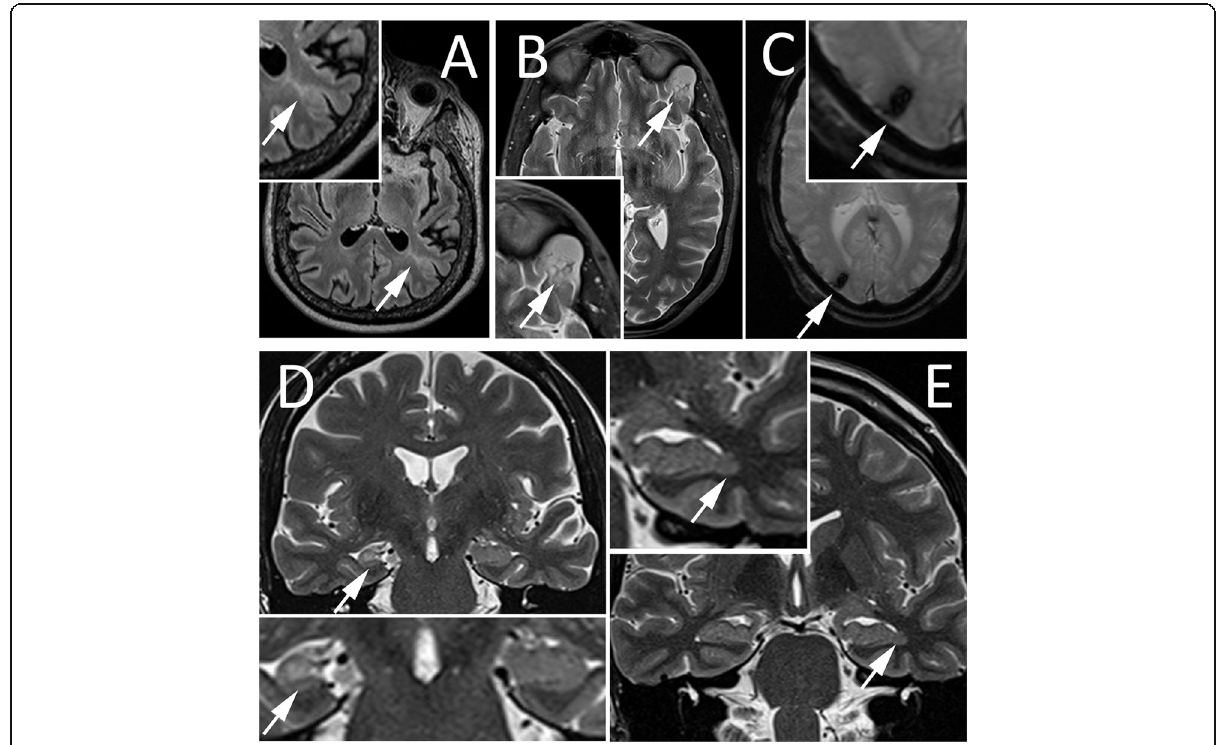
Fig. 1 Representative images of epileptogenic lesions in MRI sets C. A Left frontal cortical dysplasia, axial FLAIR. B left frontal long-term epilepsy associated tumor, axial T2. C Right occipital hemosiderin deposits after hemorrhage, axial T2*. D right hippocampal sclerosis, coronal T2. E left periventricular nodular heterotopia, coronal